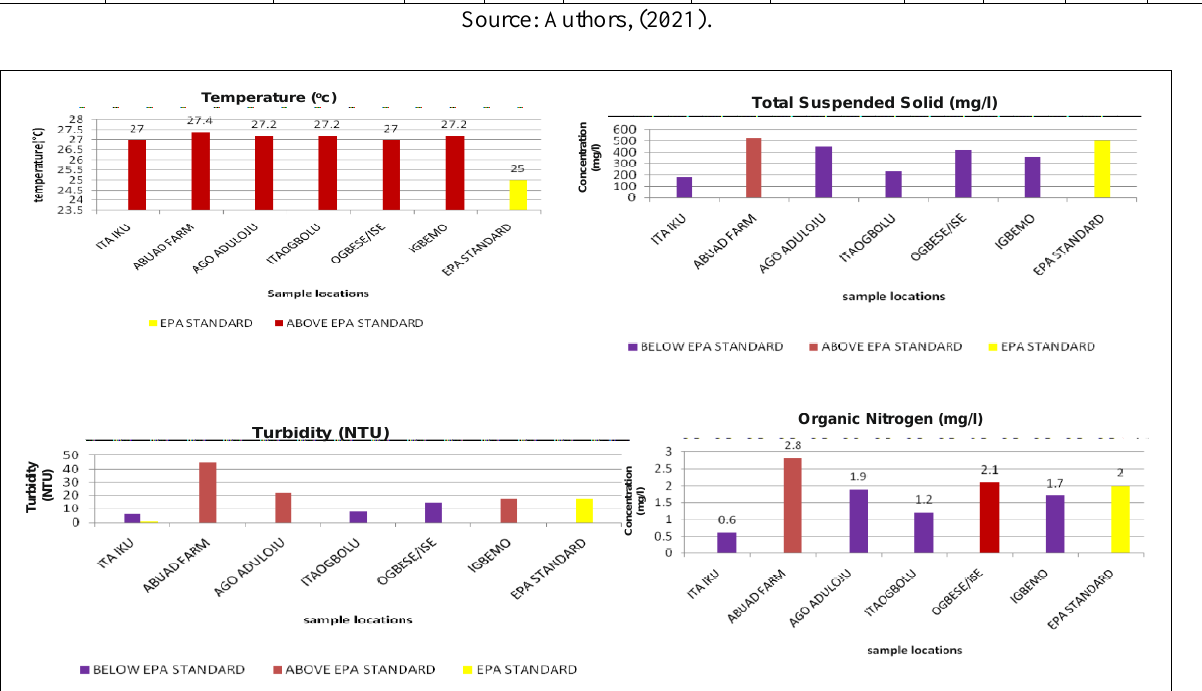
Figure 5: Some water quality parameters concentrations at various sites and in comparison with EPA standard. Source: Authors,